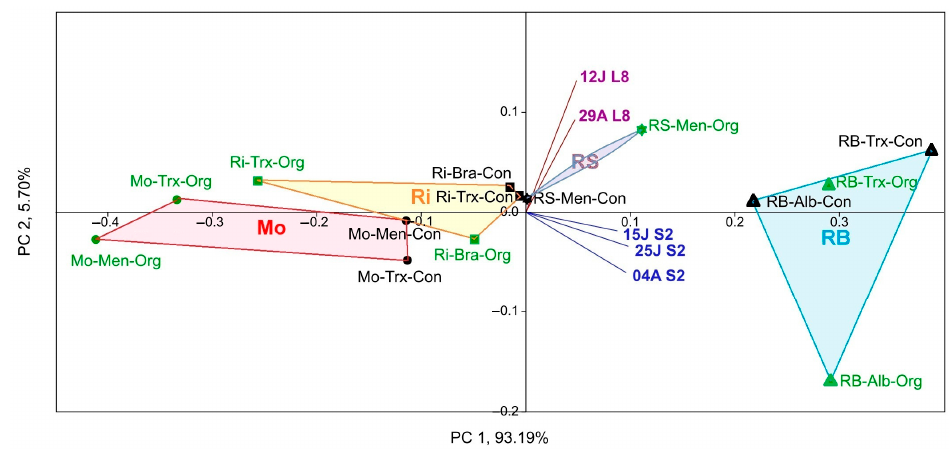
Figure 5. PCA of NDVI calculated using Sentinel-2 (S2 in dates 04A: 4 August, 25J: 25 July, and 15J: 15 July) and Landsat-8 (L8 in dates: 29A: 29 August and 12J: 12 July) per DO (circle: Monterrei, Mo; triangle: R í as Baixas, RB; asterisk: Ribeira Sacra, RS; square: Ribeiro, Ri), cultivation system (Organic, Org (green symbols); Conventional, Con (black symbols)) and cultivar (Albariño, Alb; Brancellao, Bra; Menc í a, Men; Treixadura,